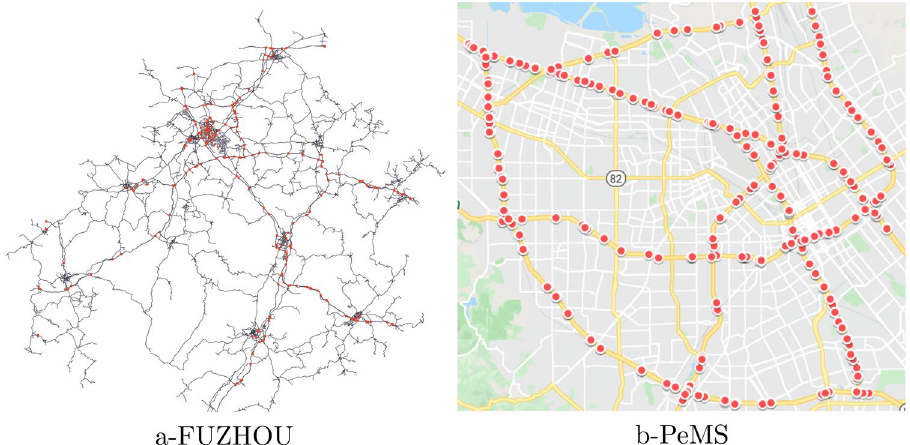
Fig. 6 Dataset descrip- tion (FUZHOU and